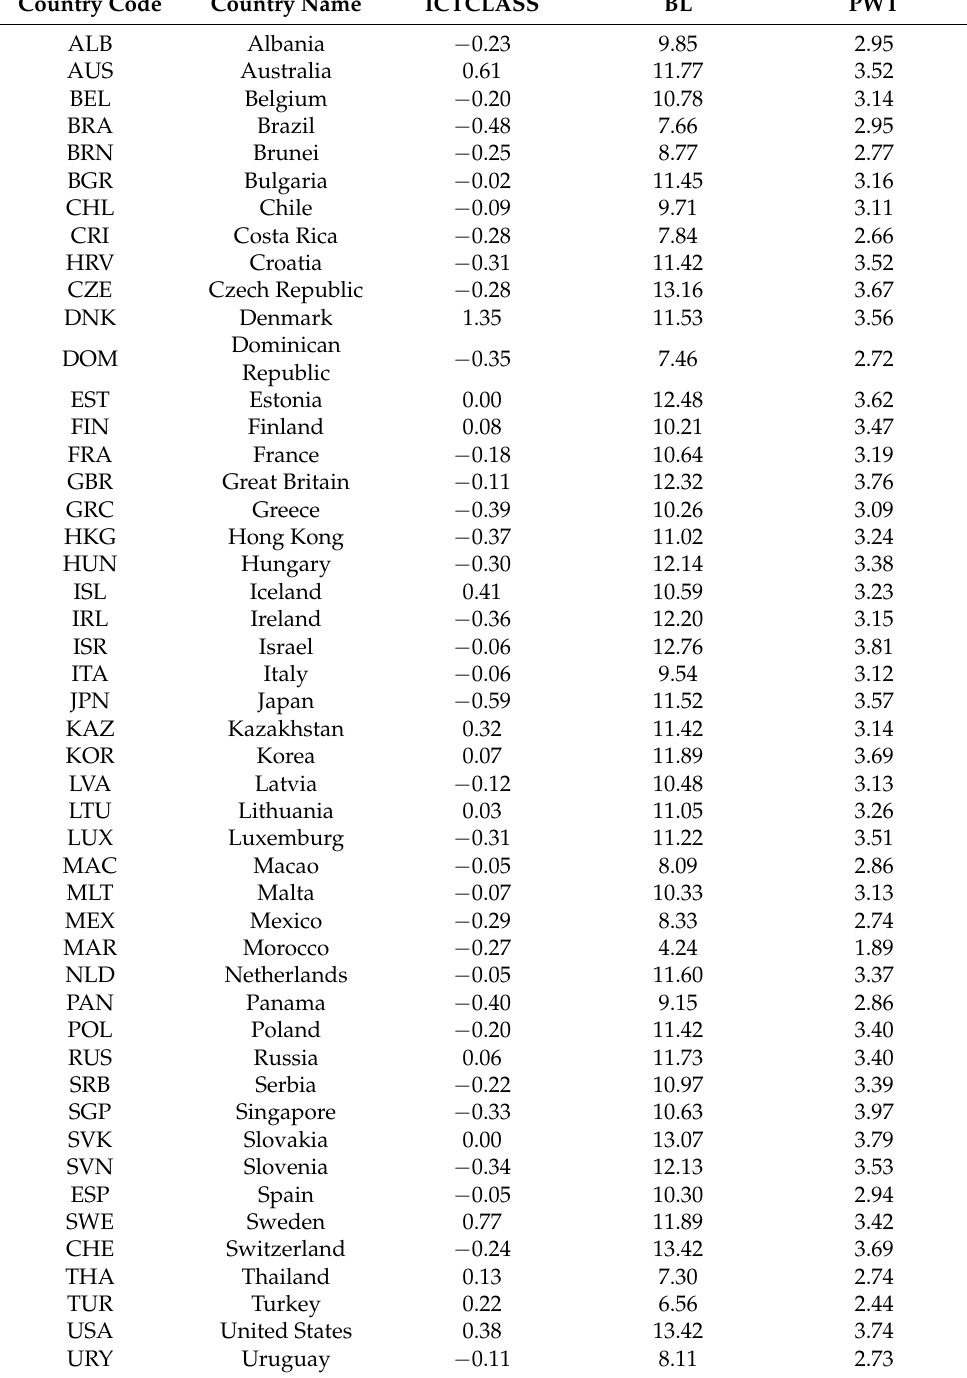
Table 1. List of countries in the sample and their average values in the PISA index subject-related ICT use during lessons (ICTCLASS), years of schooling (BL), and years of schooling